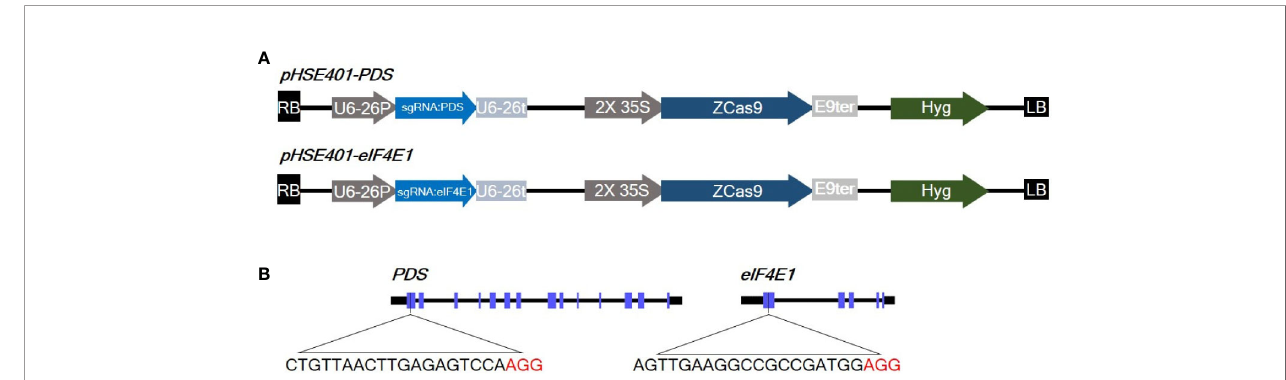
FIGURE 1 | Diagrams of the CRISPR/Cas9 vector constructs and sgRNA target sites (A) Diagram of the cassettes (pHSE401-PDS and pHSE401-eIF4E1) expressing the maize codon-optimized Cas9 gene under the control of the 35S promoter, and the PDS- and eIF4E-sgRNA sequence driven by the Arabidopsis U6- 26 polymerase III promoter. (B) Diagram of the CRISPR/Cas9 target sites within PDS and eIF4E1 . The sgRNA target sequences are shown in black letters, followed by protospacer-adjacent motif (PAM) sequences in